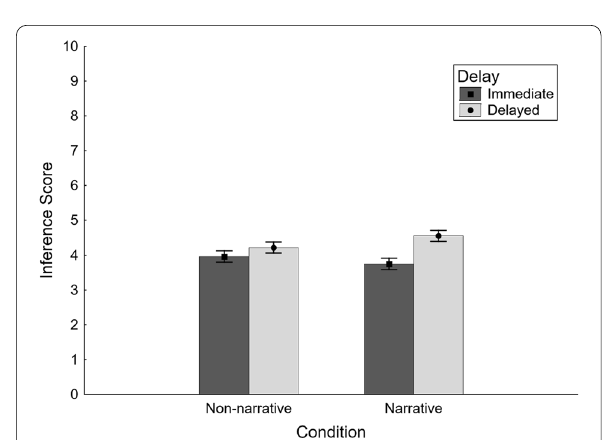
Fig. 4 Mean myth-belief-change scores across conditions in Experiment 3; theoretically-possible range was bars indicate within-subjects standard error of the mean (Morey 2008)